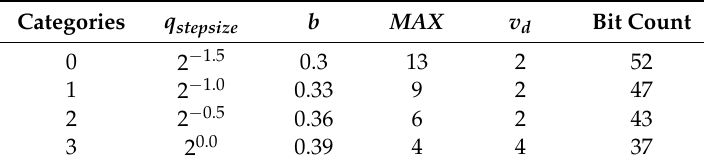
Table 1. The coding parameters for different